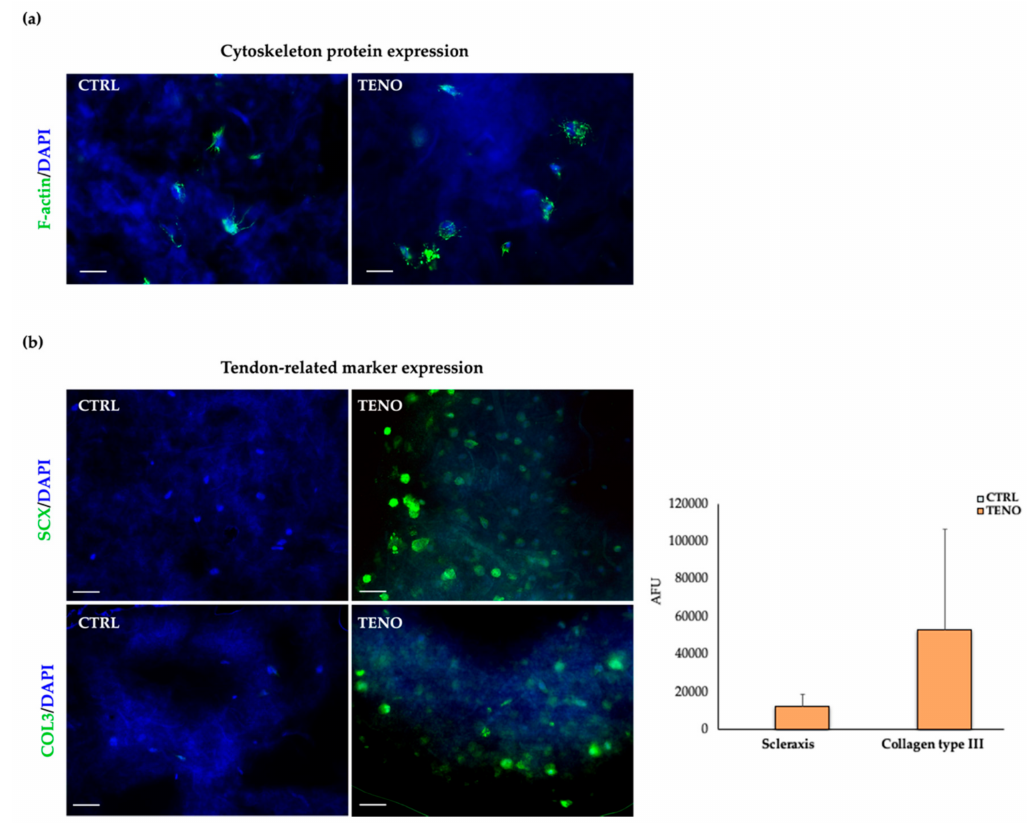
Figure 7. Cytoskeleton- and tendon-related marker expression: ( a ) representative images of both CTRL- and TENO-cultured ASCs embedded in NFC / A sca ff olds stained at day 14 of culture with phalloidin (green) for F-actin detection and counterstained with DAPI to visualize cell nuclei (blue) (32 × magnifications; 10 µ m scale bar); ( b ) on the left, representative images of both CTRL- and TENO-cultured ASC constructs stained with scleraxis (SCX) and collagen type III (COL3) at days 3 and 14 of di ff erentiation, respectively, visualized with Alexa Fluor 488 (green) and counterstained with DAPI (blue) (20 × magnification; 10 µ m scale bar); on the right, the level of cellular fluorescence intensity from fluorescence microscopy images ( N = 3) expressed as average ± sem of arbitrary fluorescence units